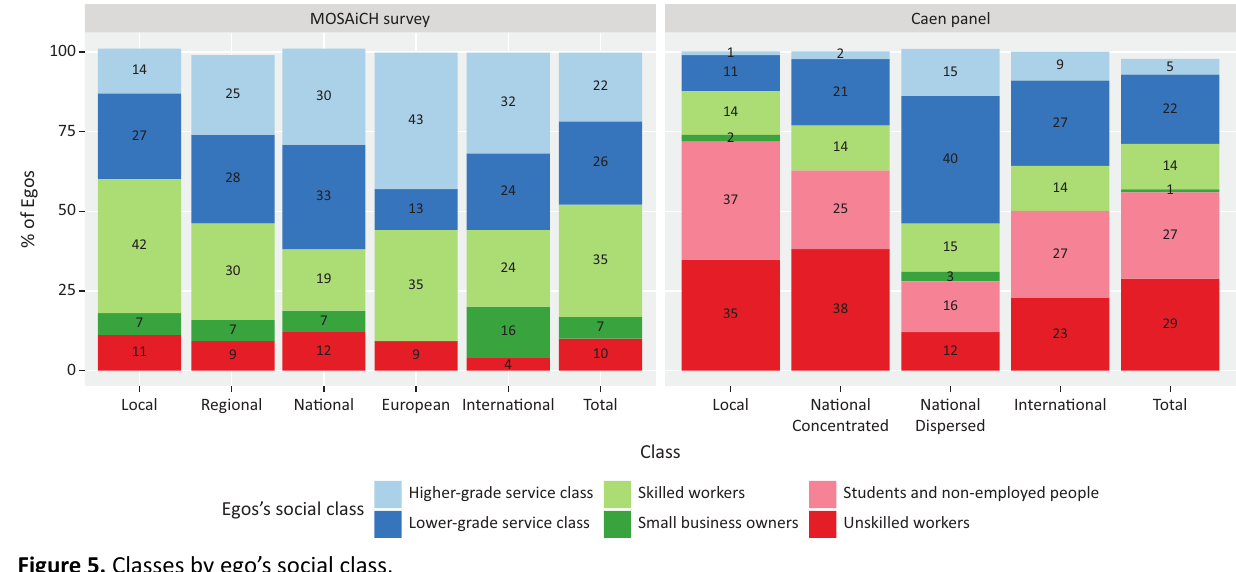
Figure 5. Classes by ego’s social